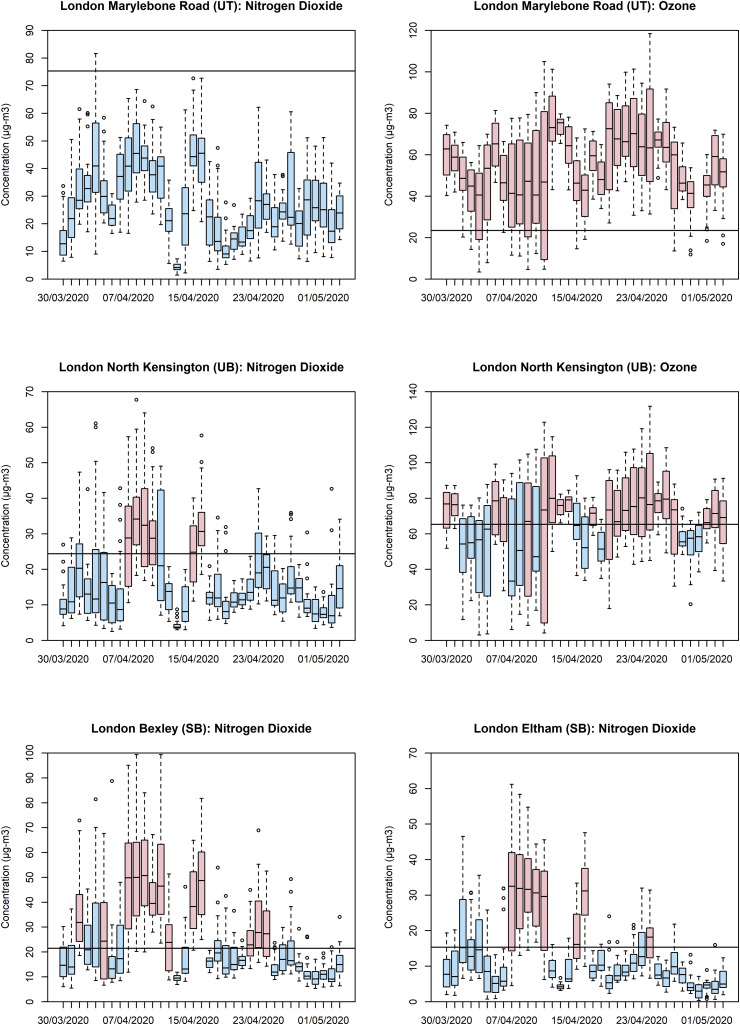
Box-and-whisker plots comparing the distribution of hourly pollution concentrations for days in weeks 14–18 of 2020, with the median daily-median concentration for a comparable period in 2017–19.